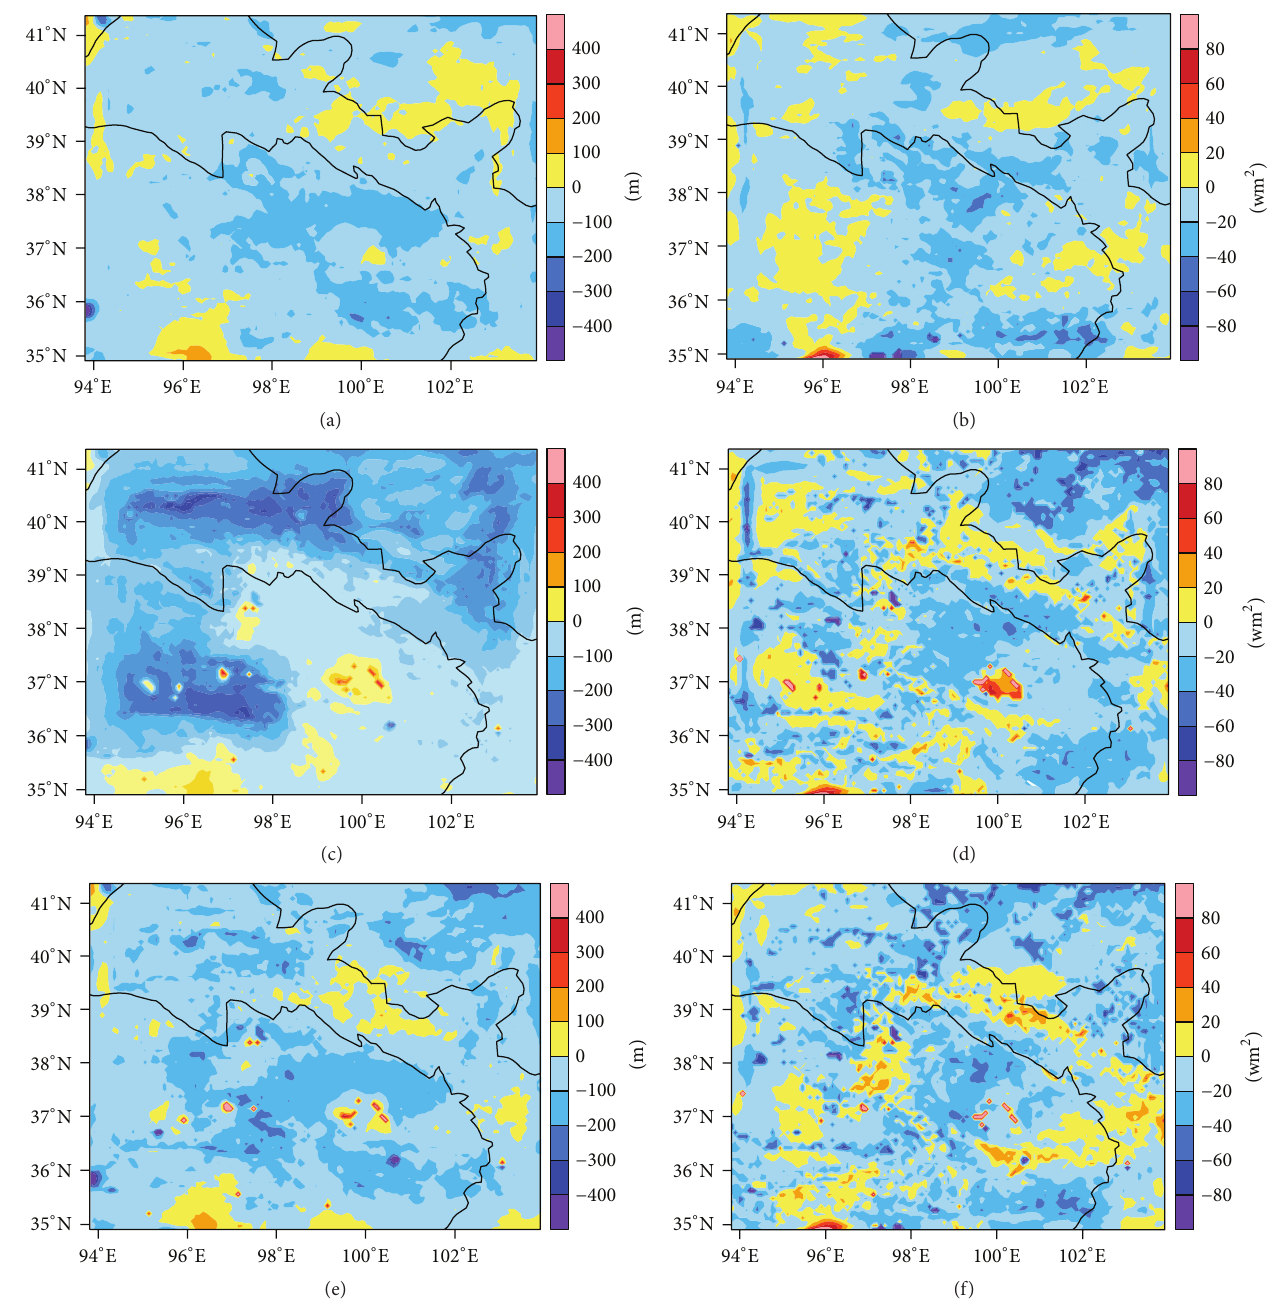
Figure 9: Spatial difference for mean boundary layer height (BLH) and mean net energy flux in June (NE): (a) INTL-CTRL for BLH; (b) INTL-CTRL for NE; (c) MODS-CTRL for BLH; (d) MODS-CTRL for NE; (e) INMO-CTRL for BLH; (f) INMO-CTRL for